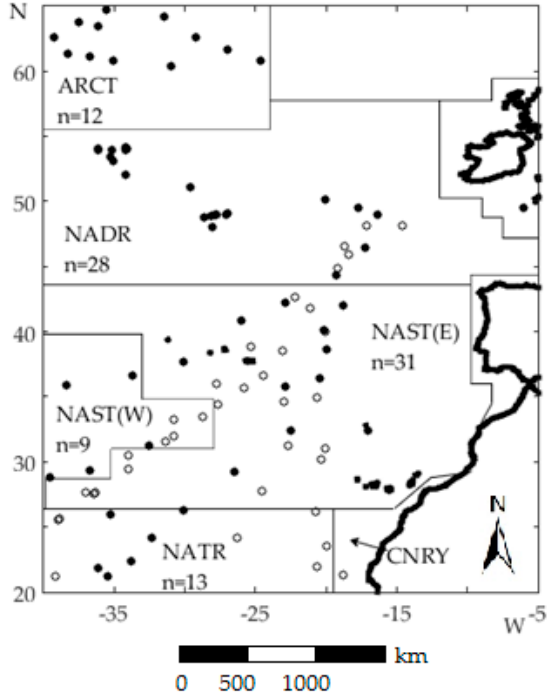
Figure 1. Stations sampled for the determination of in situ integrated daily water column primary production ( PP eu ) in the North East Atlantic. Filled circles are stations sampled in summer; open circles are stations sampled in autumn.